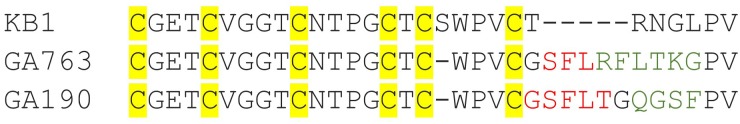
The sequence alignment of KB1, GA763 and GA190.The first and second hotspot-containing peptides are represented in red and green, respectively. Cysteine residues are highlighted by yellow.